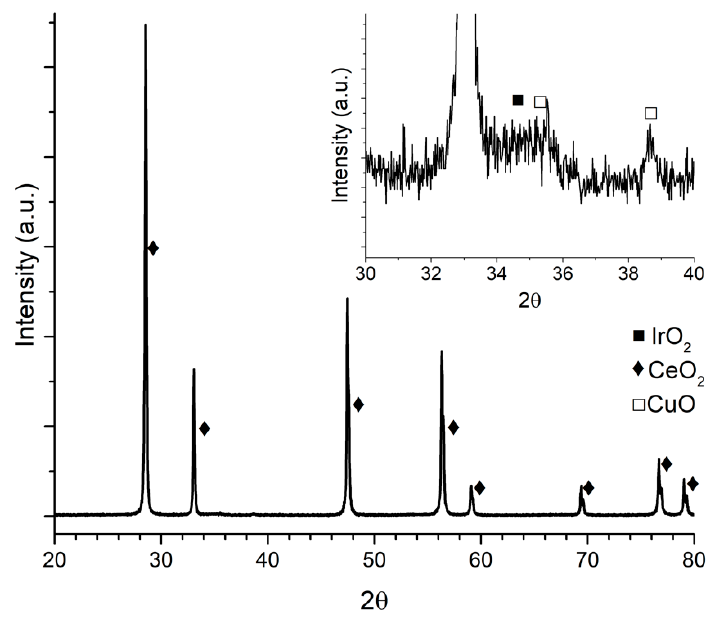
Figure 3. IrCu/CeO 2 diffraction pattern.